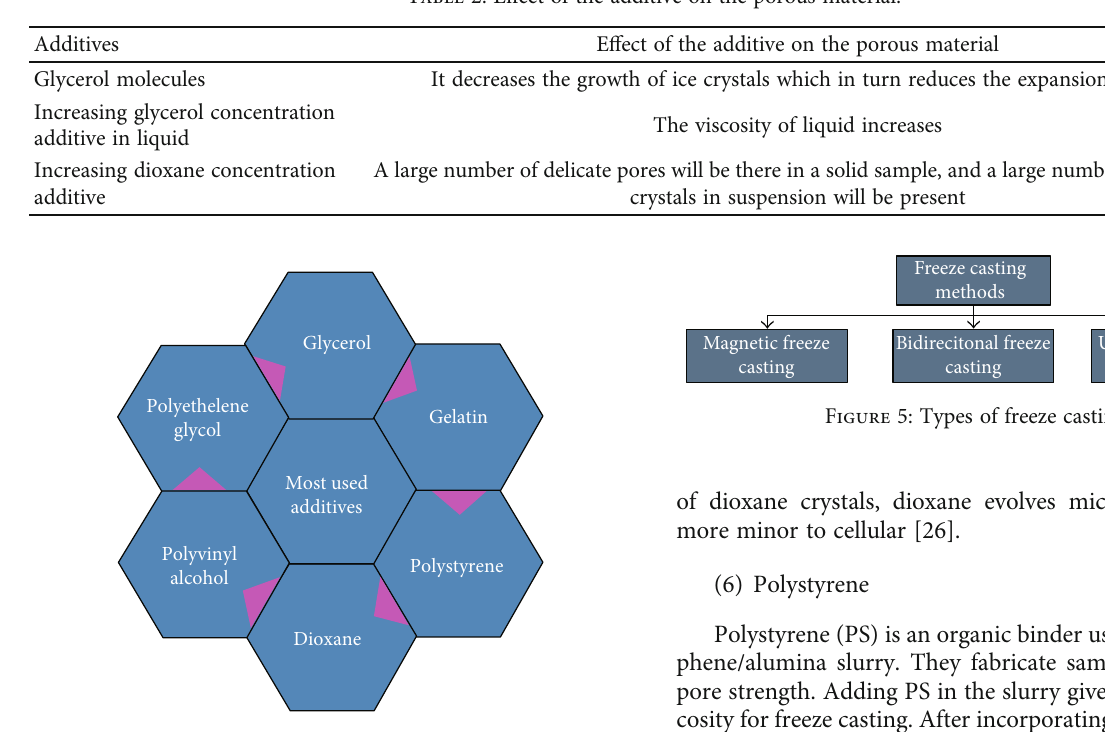
Figure 4: Most used additives.